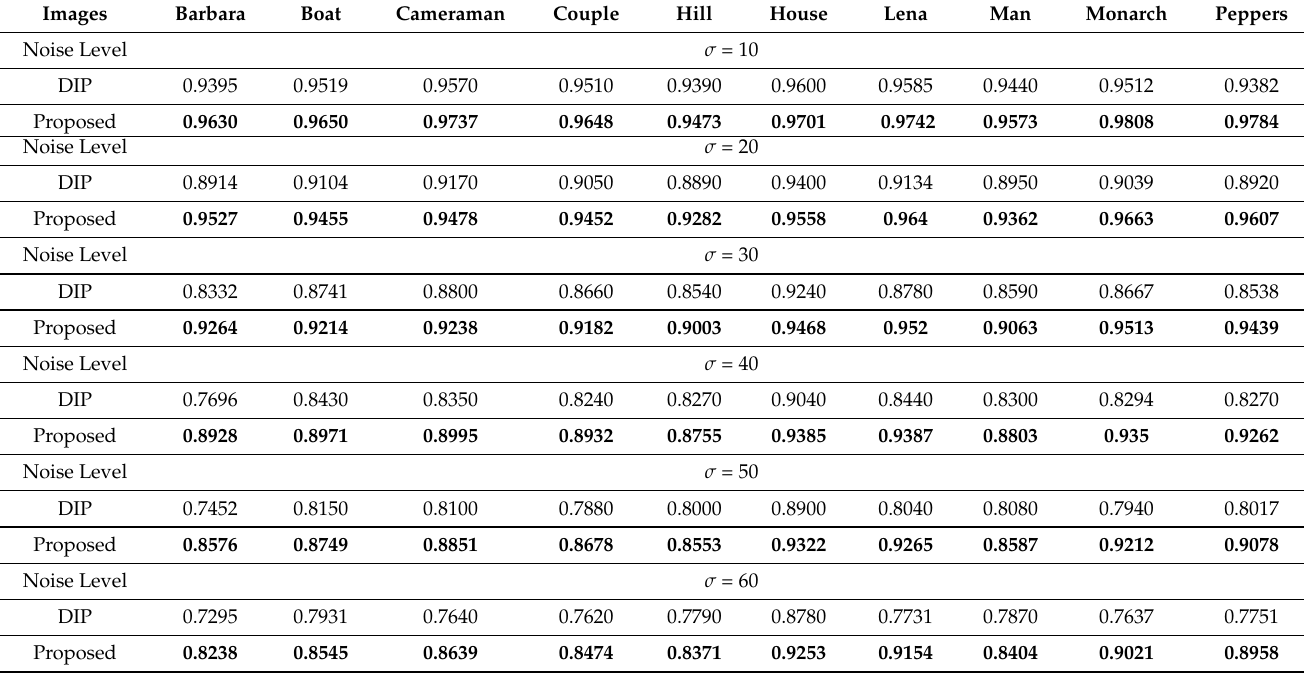
Table 3. SSIM results of two methods on 10 commonly used images with various noise levels.